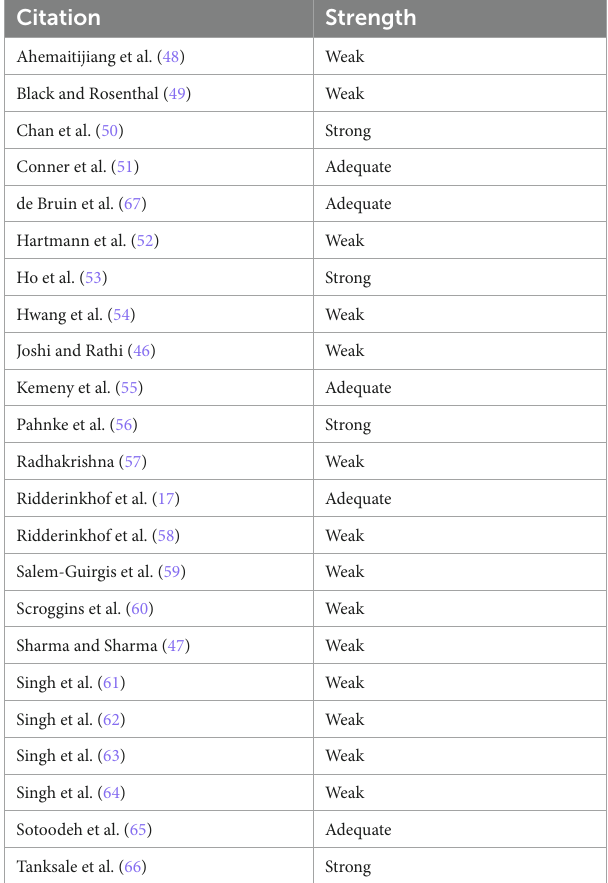
TABLE 6 Strength ratings of the research